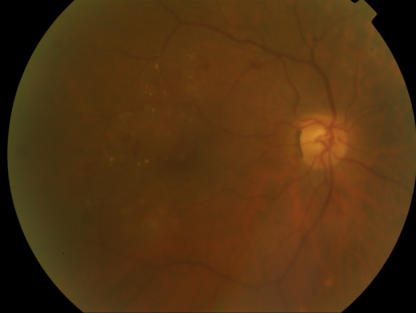
Very Mild Diabetic Retinopathy